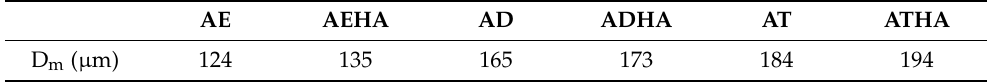
Table 2. Diameters of precursor/hybrid